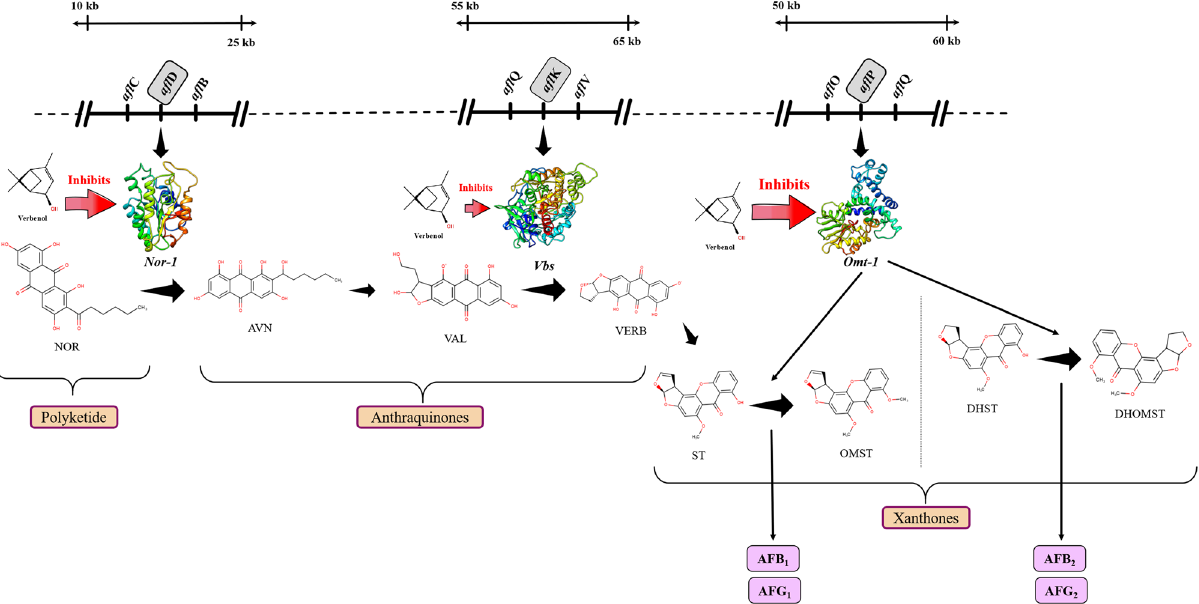
Figure 6. Schematic representation of molecular mechanism of action of anti-aflatoxigenic activity of